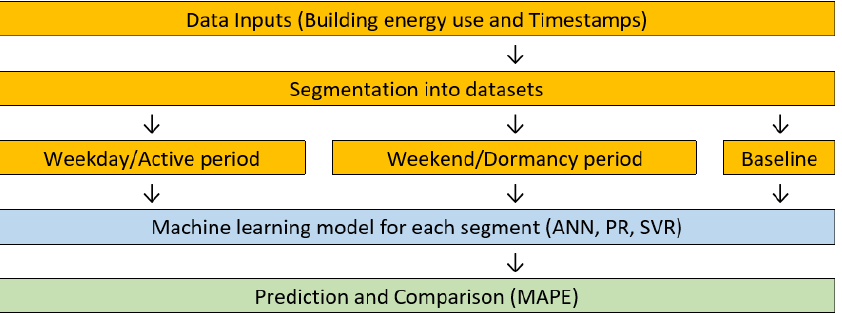
Figure 1. A flowchart of the creation and comparison of building energy prediction models based on segmented and unsegmented data.